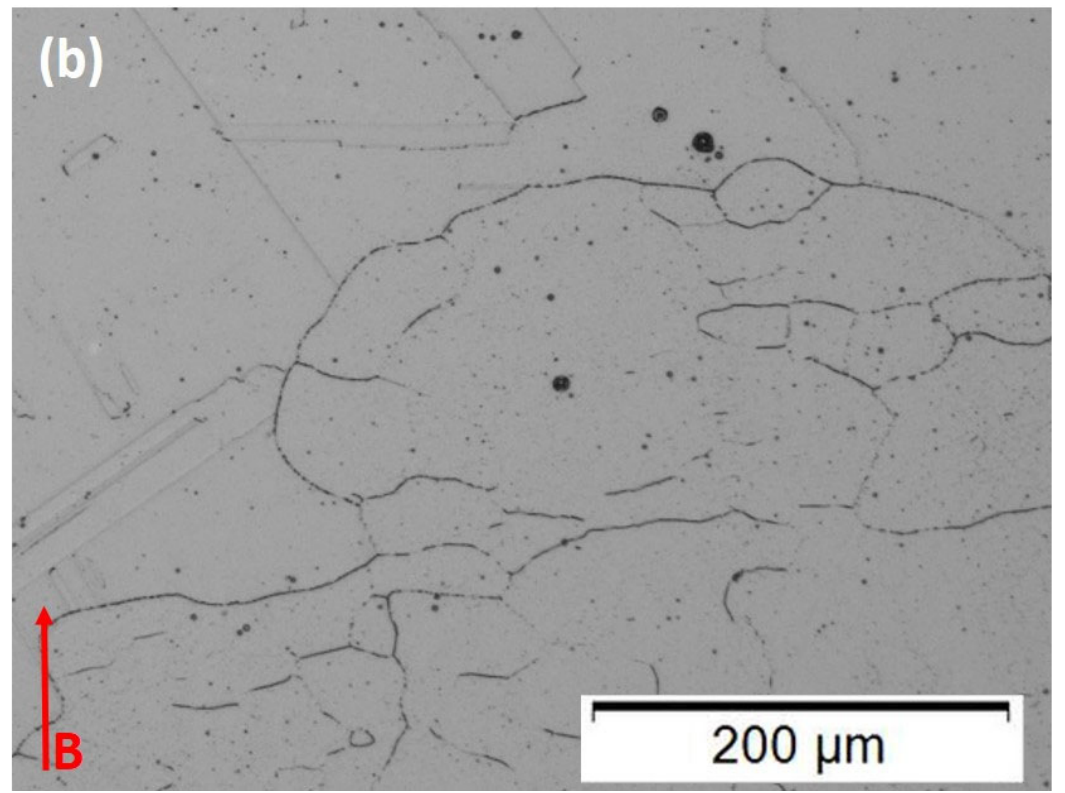
Figure 5. Heat-treated samples. ( a ) 50 µm layer thickness; ( b ) 100µm layer thickness. B denotes the build direction.